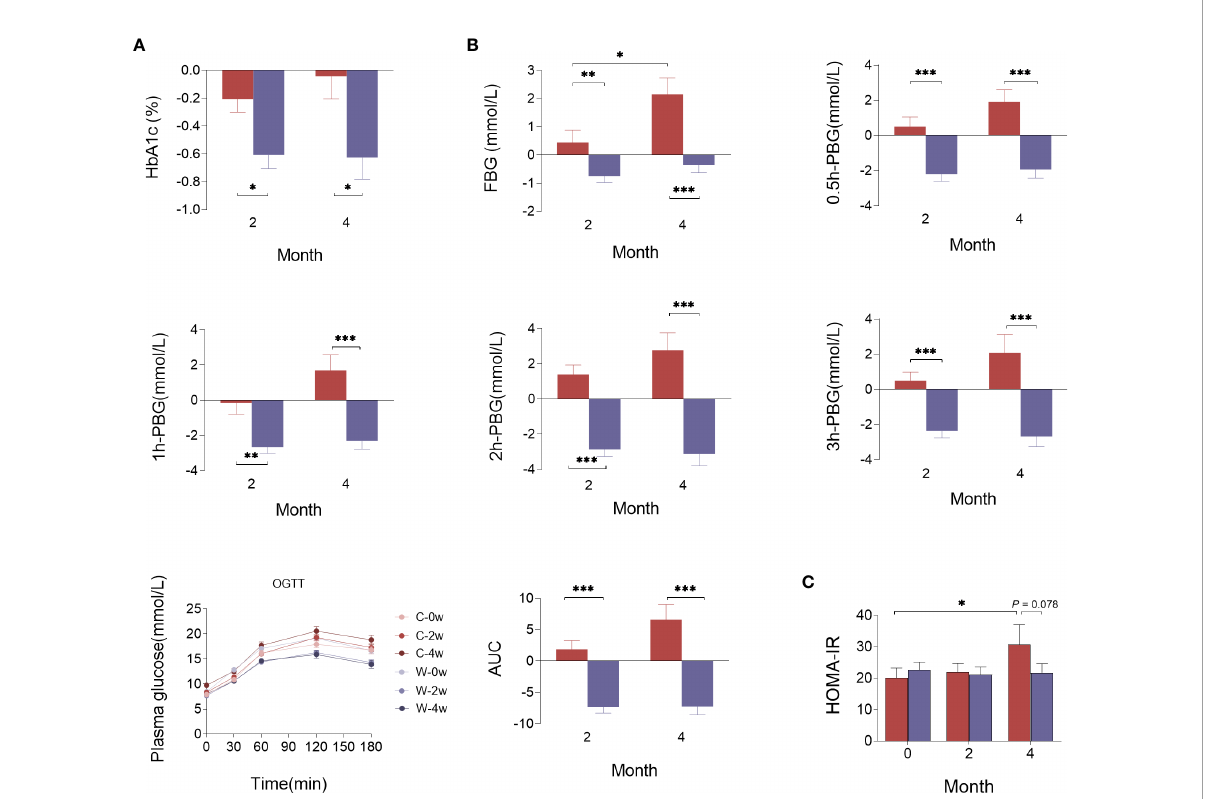
FIGURE 1 Effects of WCBE on glucose metabolism indices at the end of the 2nd month and 4th month. The change in HbA1c (A) , fasting and postprandial blood glucose levels (B) , and HOMA-IR (C) . *P < 0.05; ** P < 0.01; *** P <